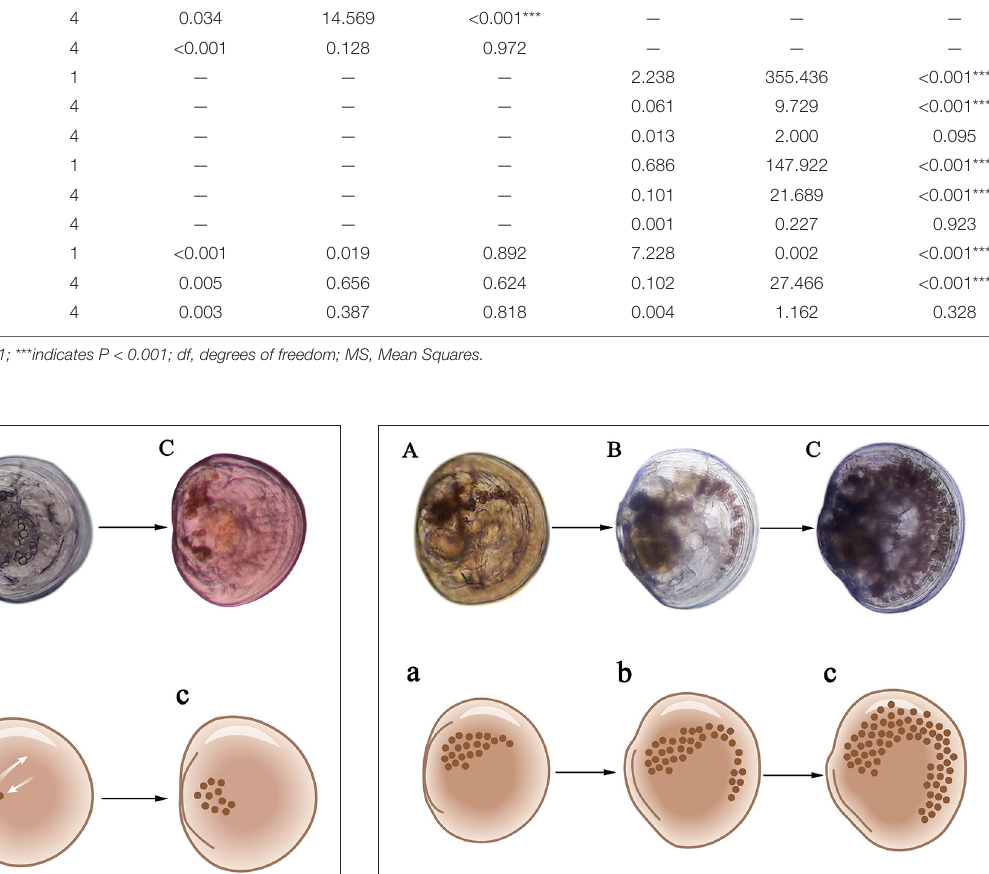
artificial runway system with continuously circulating water.